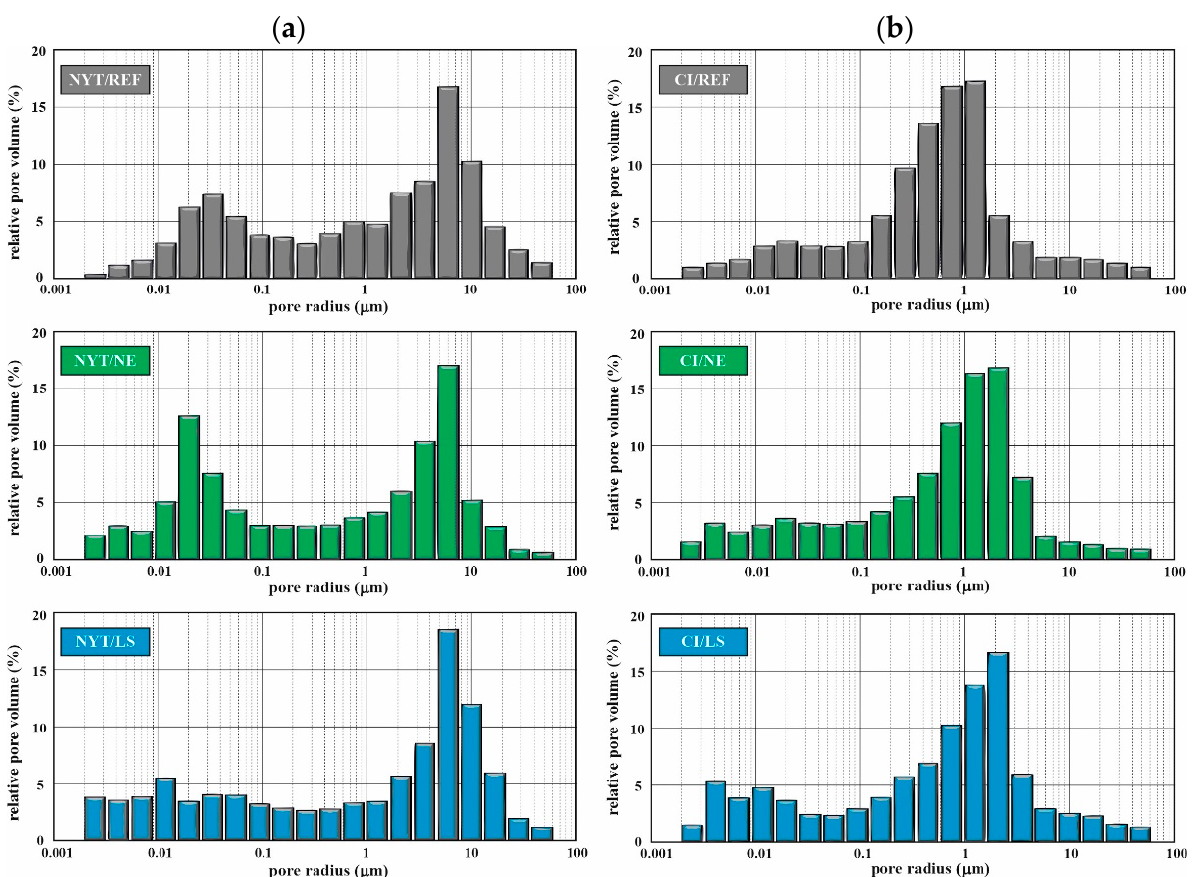
Figure 4. Pore radius distribution of NYT ( a ) and CI ( b ) samples, untreated (REF) and treated with Nano Estel (NE) and lithium silicate